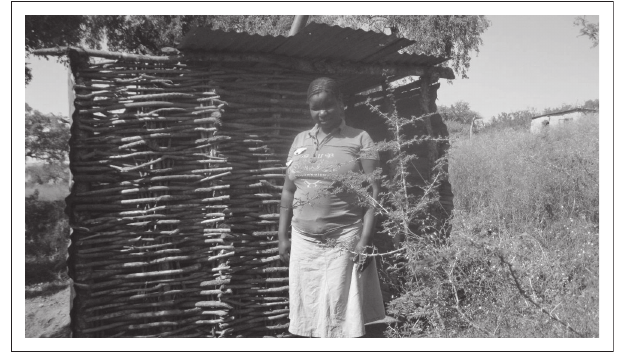
FIGURE 7: Latrine built after Community Led Total Sanitation sensitisation in Matsanjeni Constituency.